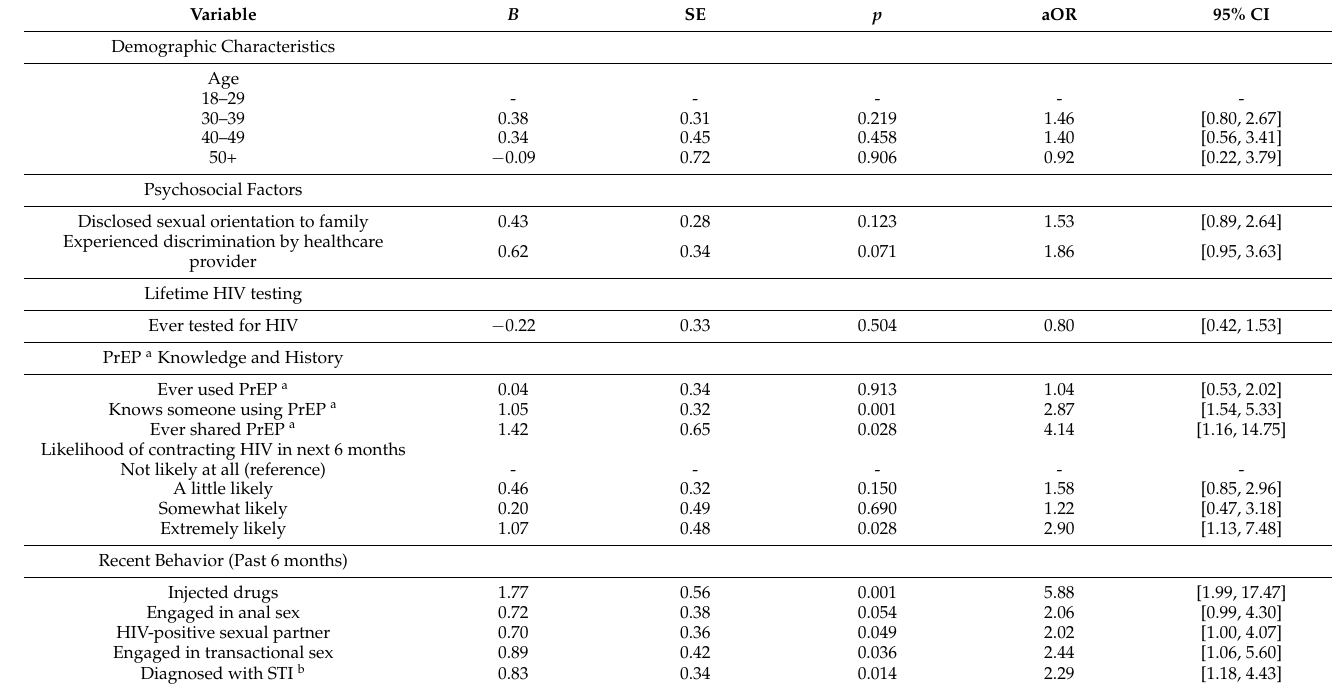
Table 2. Full multivariate logistic regression analysis of correlates of recent engagement in